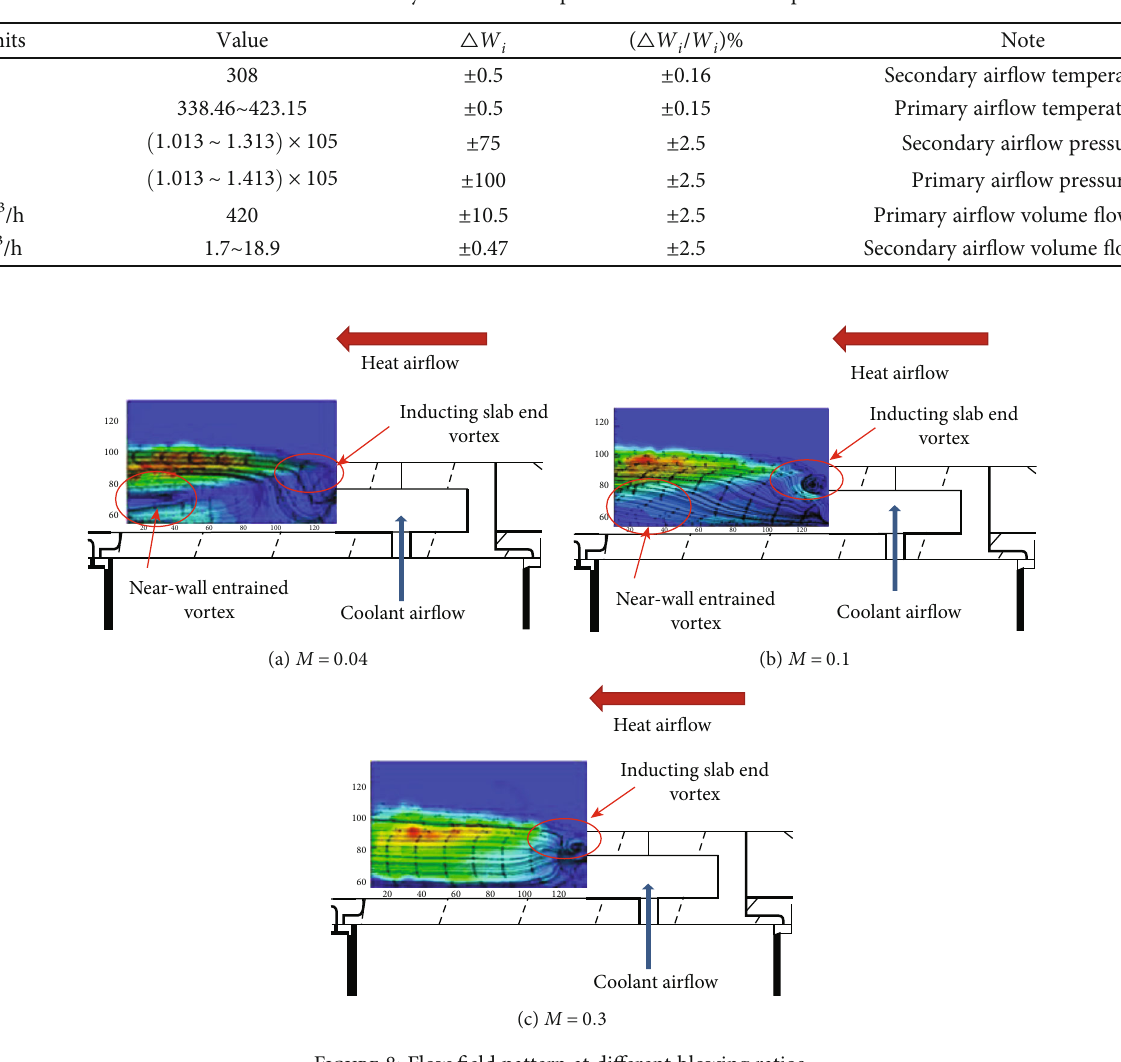
Table 2: Uncertainty of fl ow fi eld experimental measurement parameters.